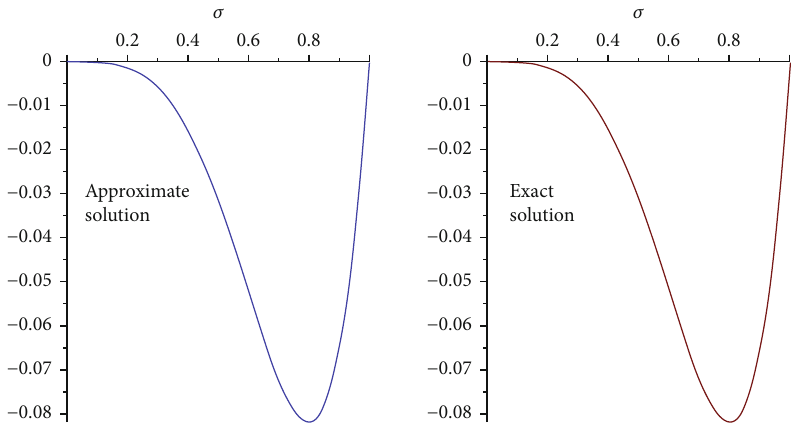
Figure 5: 2D plots of the exact and approximate solution for δ = 1 of Example